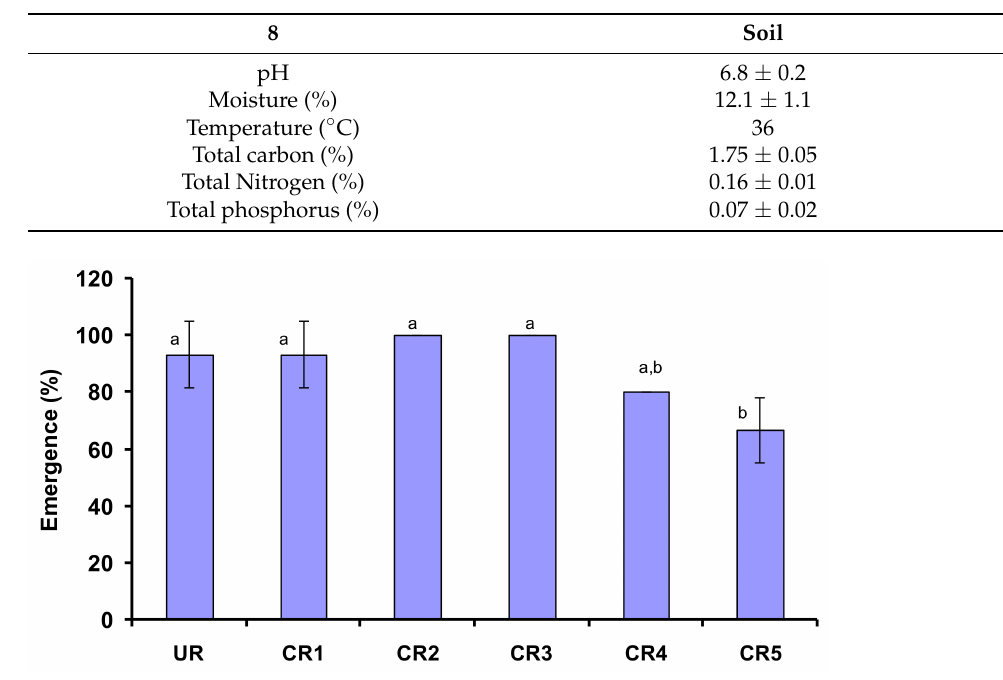
Figure 1. Percentage emergence of different treatments at various POS concentrations. Different letters are significantly different based on Tukey’s post-hoc analysis ( p < 0.05). Bars represent means ± standard deviation ( n = 3). UR is an uncontaminated rhizosphere and CR 1 to CR5 represent contaminated rhizosphere with POS from 1 to 5% w / w